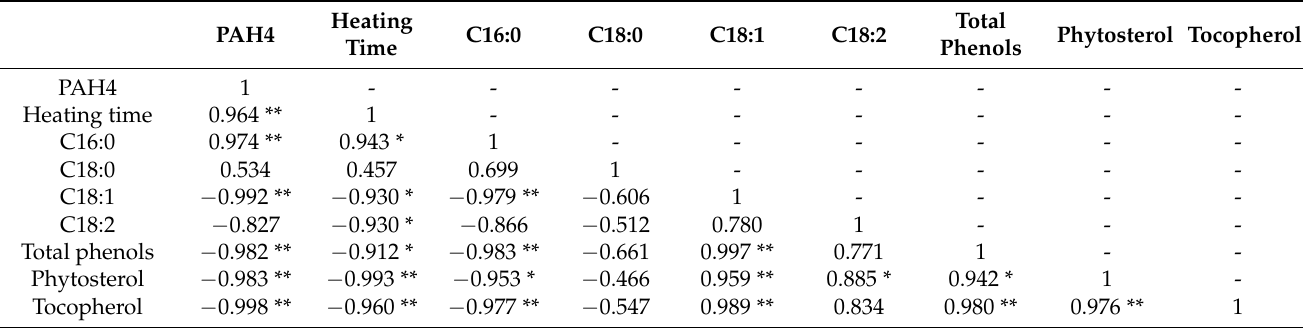
Table 2. Pearson correlation coefficients of heating time, fatty acid composition, lipid companion, and PAH4 in crude C. Oleifera